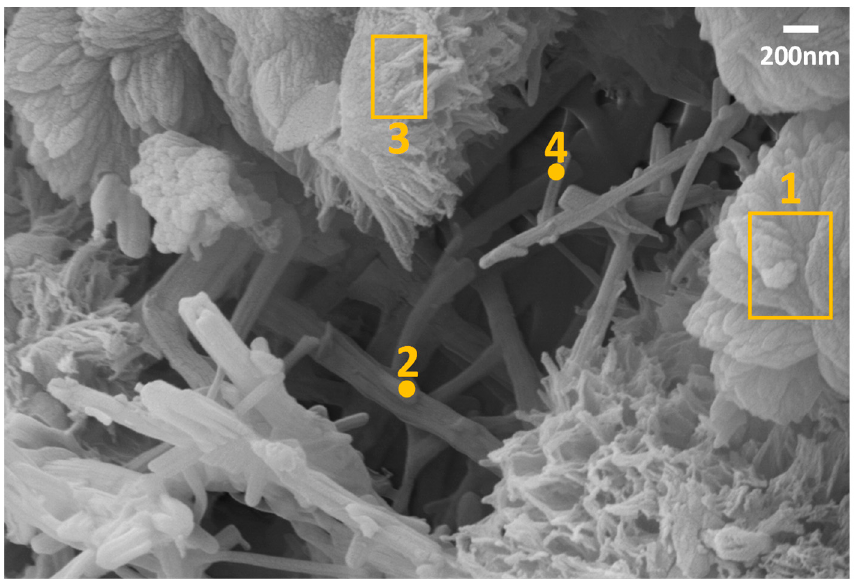
Figure 15. SEM analysis of EOGO nanoflakes-cement composite (0.05% of EOGO) sample with different resolutions.